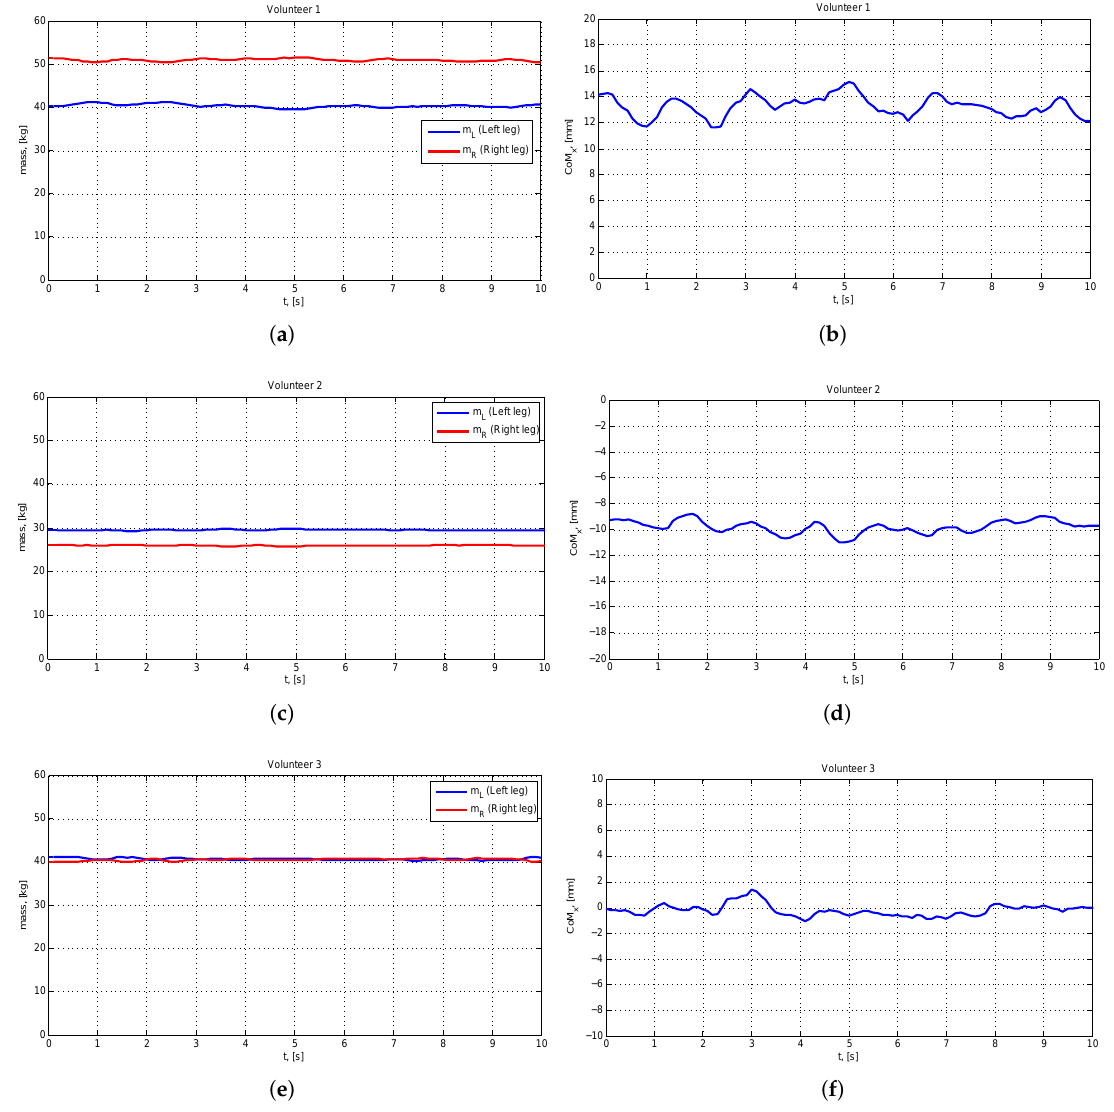
Figure 18. Measurements of loads on the left m L and right m R legs and the CoM along the x -axis ( CoM x ) for three chosen volunteers: ( a ) Volunteer 1, the loads on the left m L and the right m R legs; ( b ) Volunteer 1, CoM along the x -axis ( CoM x ); ( c ) Volunteer 2, the loads on the left m L and the right m R legs; ( d ) Volunteer 2, CoM along the x -axis ( CoM x ); ( e ) Volunteer 3, the loads on the left m L and the right m R legs; and ( f ) Volunteer 3, CoM along the x -axis ( CoM x